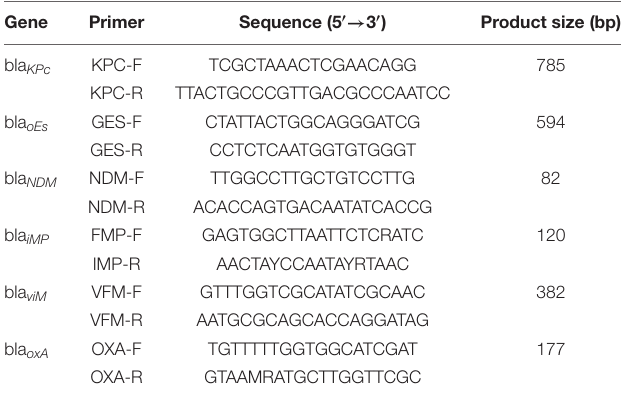
TABLE 1 | Oligonucleotide primers used for polymerase chain reaction